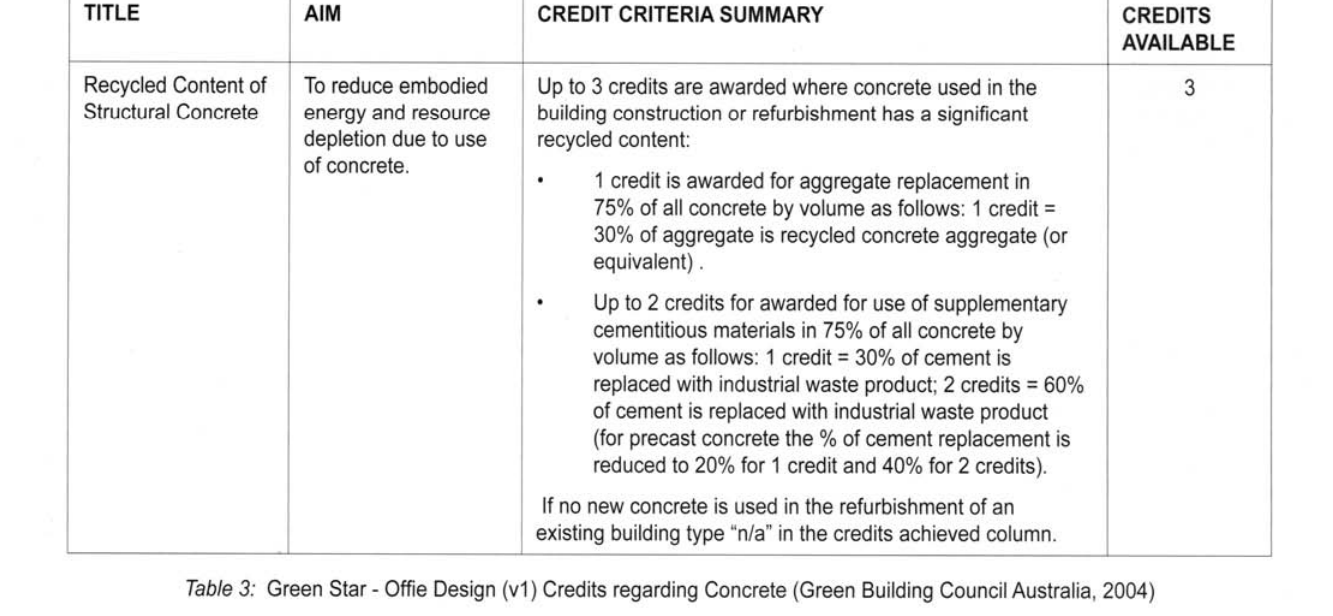
Table 3: Green Star - Offie Design (v1) Credits regarding Concrete (Green Building Council Australia, 2004)